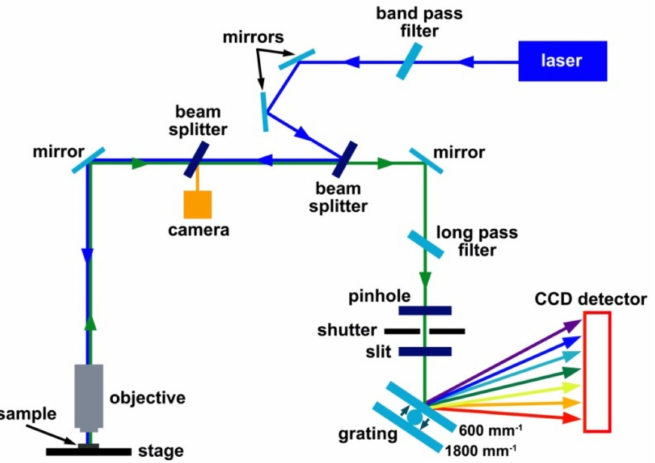
Figure 2. The schematics of Horiba Jobin Yvon LabRAM HR800 Raman spectroscopy system. The main parts of the setup are labeled. The incoming laser beam is shown in blue. The Raman scattered light is shown in green. The directions of the laser beams are guided by